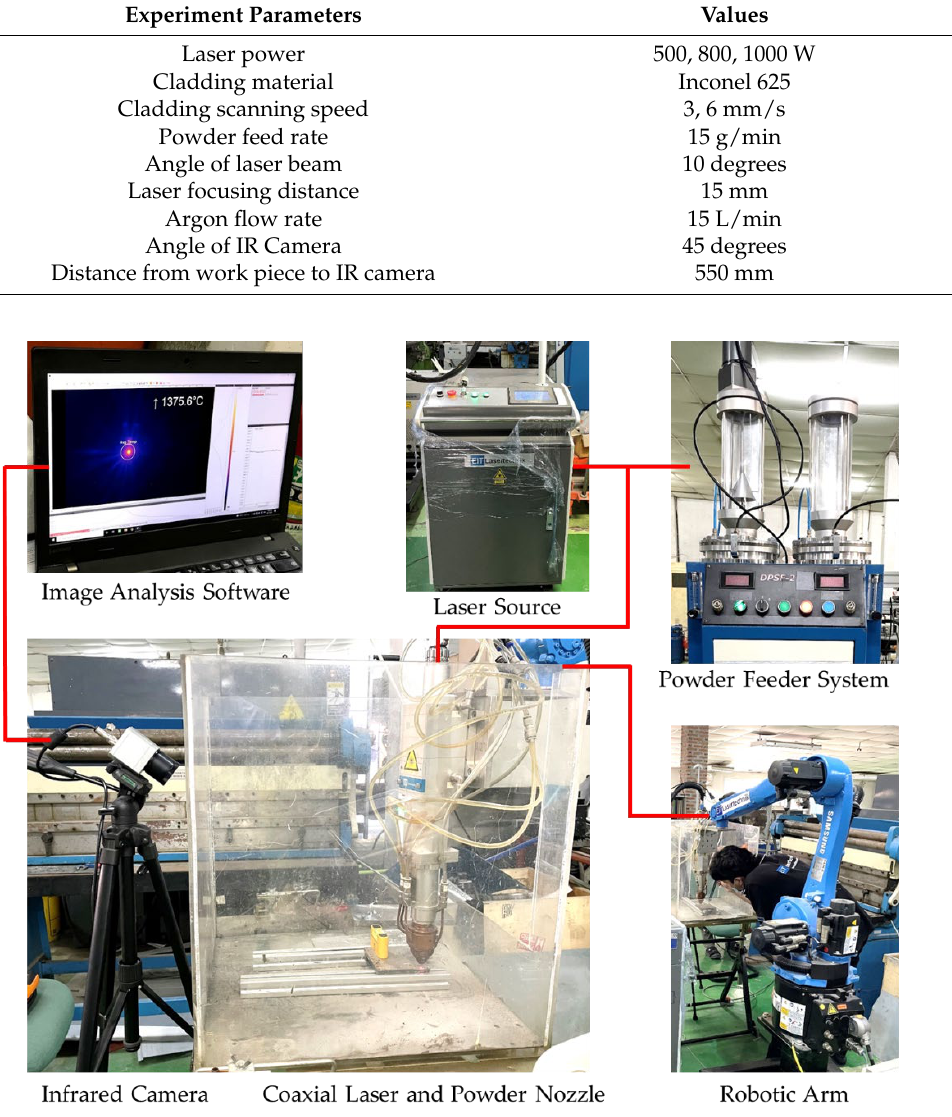
Figure 2. Online monitoring of laser-cladding experiment’s equipment.